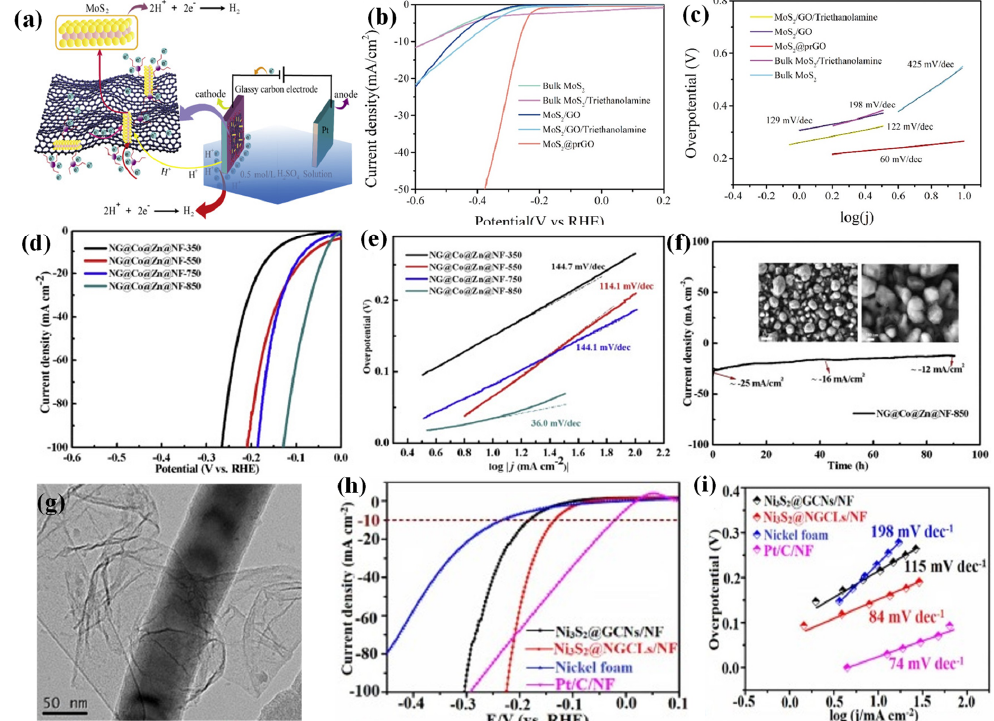
Figure 6. ( a ) Scheme of catalytic performance of partially reduced graphene oxide and molybdenum disulfide (MoS 2 @pr- GO) composite, ( b ) polarization curves and ( c ) relevant Tafel slopes of bulk MoS 2 , GO/MoS 2 , bulk MoS 2 /triethanolamine, GO/MoS 2 /triethanolamine and MoS 2 @prGO composites [70]; ( d ) The hydrogen evolution polarization curves and ( e ) Tafel plots of NG@Co@Zn@NF catalysts, ( f ) LSV curves of the NG@Co@Zn@NF-850 catalyst before and after 1000 CV cycles in the stability test [72]; ( g ) TEM image of as-synthesized Ni 3 S 2 @NGCLs/NF, ( h ) Polarization curves and ( i ) Tafel slopes of Ni 3 S 2 @GCNs/NF, Ni 3 S 2 @NGCLs/NF, Ni foam and Pt/C/NF, respectively [73].